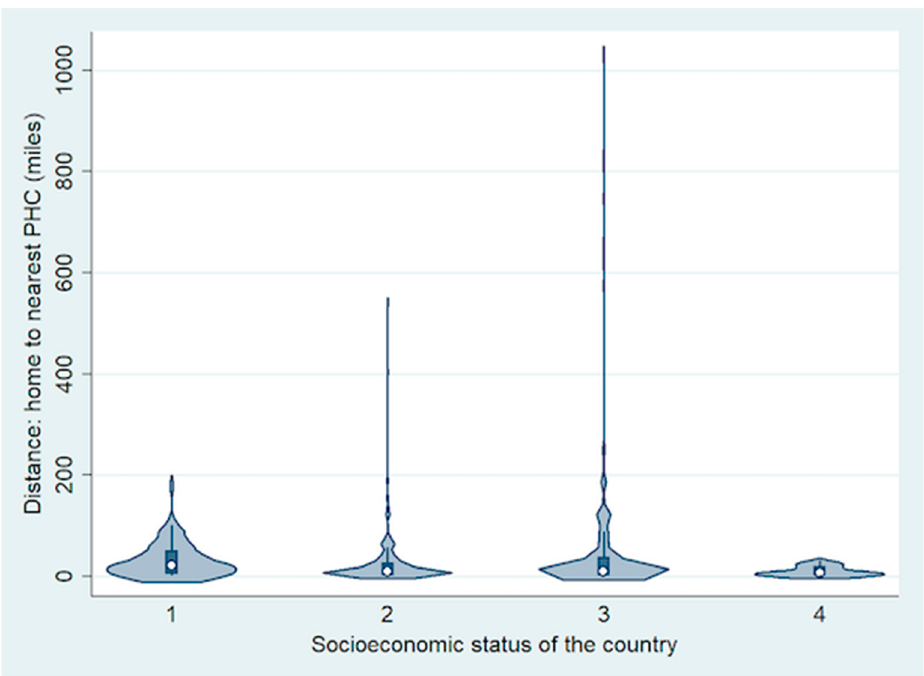
Figure 2. Violin plot showing the difference in distance from home to the nearest primary healthcare centre (PHC) based on socioeconomic status of the country. The mean lag time between detection of first symptom to visit to RB treatment centre was 150 days (median, 69 days; range, 0–1128 days) (Table 1 and Figure 3). Based on anal- ysis by country income level, the mean lag time decreased with increasing national income level. It was 303 days for LIC (median, 251 days; range, 33–846 days), 180 days for LMIC (median, 86 days; range, 0–1128 days), 92 days for UMIC (median, 37 days; range, 1–697 days) and 56 days for HIC (median, 18 days; range, 0–366 days) (difference between groups; p = 0.0007). Table 1. Demographics and presenting features of 692 retinoblastoma patients from 10 countries.